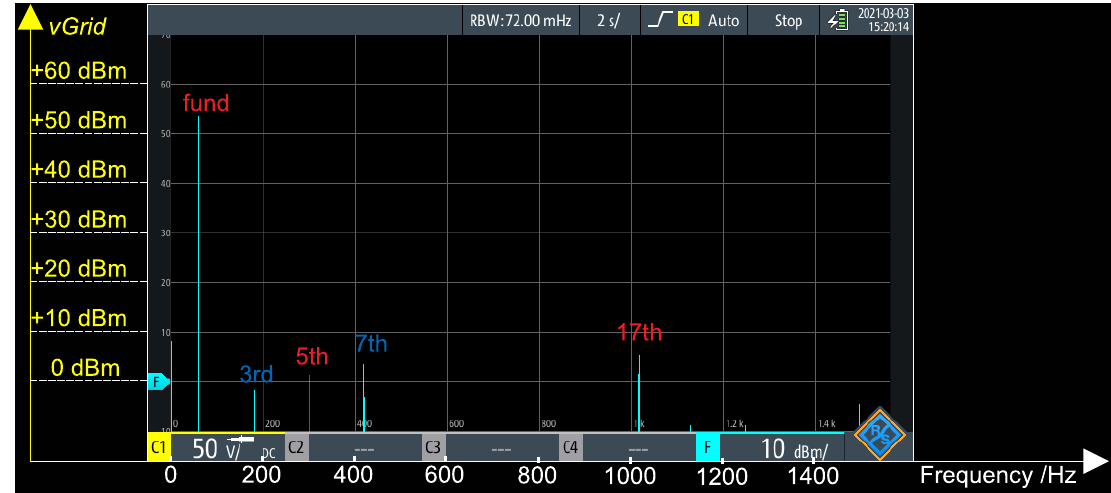
Figure 12. FFT of generator’s voltage v Grid .